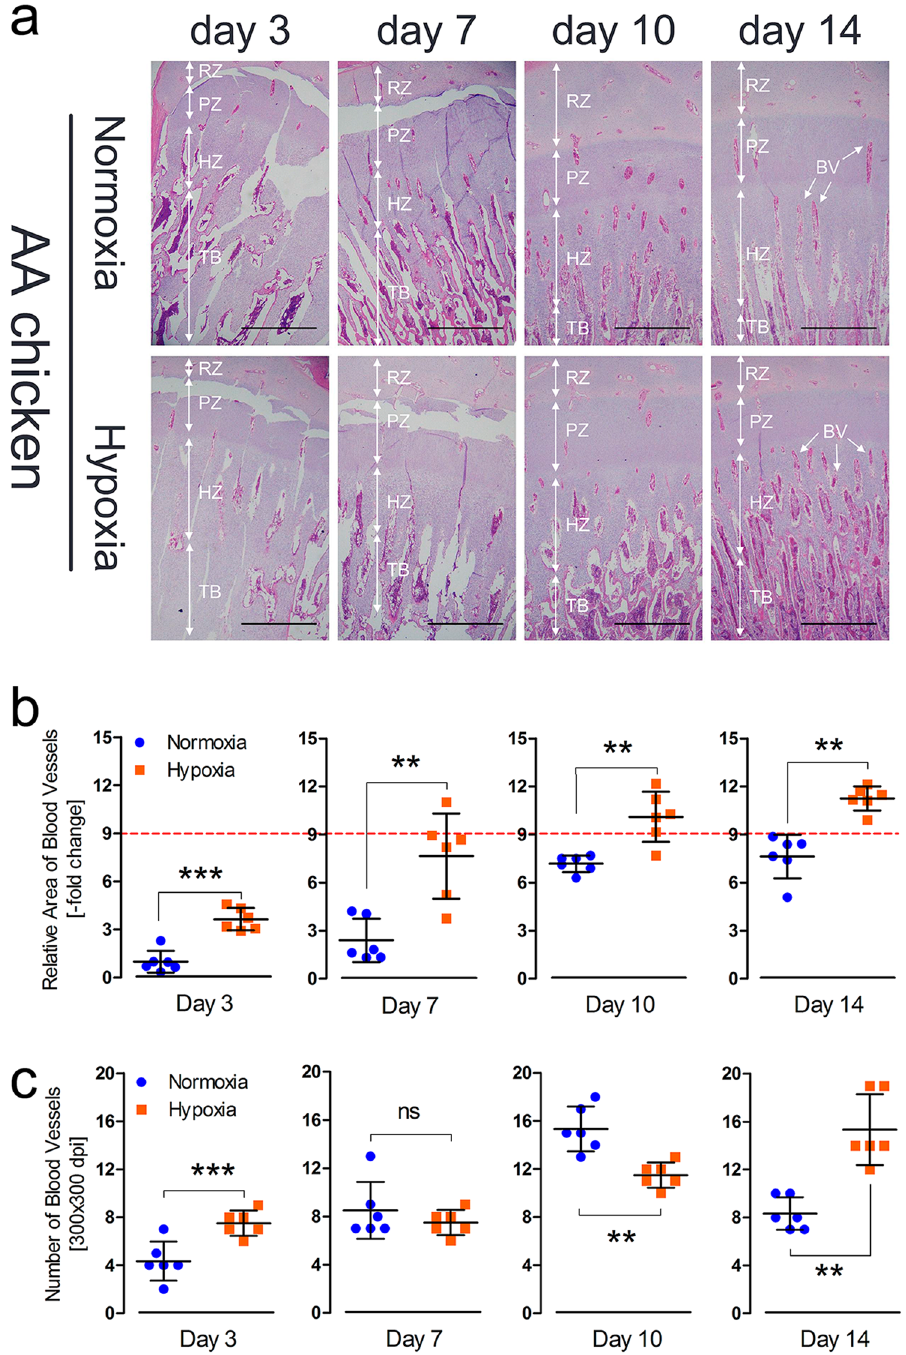
Figure 4. Hypoxia increases tibial vascular distribution in the hypertrophic chondrocyte zone. ( a ) Tibial vascular distribution clearly increased in the hypoxia group compared to the normoxia group. The arrows indicate the BVs (blood vessels); RZ, resting chondrocyte zone; PZ, proliferative chondrocyte zone; HZ, hypertrophic chondrocyte zone; and TB, trabecular bone. Scale bar = 500 µ m. ( b , c ) The relative BV area and number were determined from two isolated groups using Image-Pro ® Plus 6.0. The value for the red line as the reference in this figure is 9. Student’s t -test, ** p < 0.01, *** p < 0.001, n = 6; Error bars indicate SD. ns, not